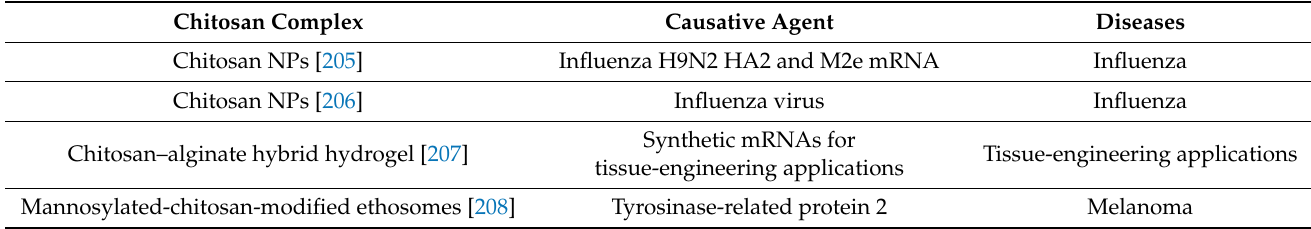
Table 8. Application of chitosan-based complexes in RNA